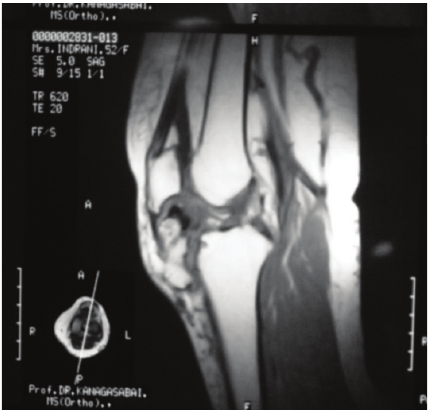
Figure 3: MRI of left